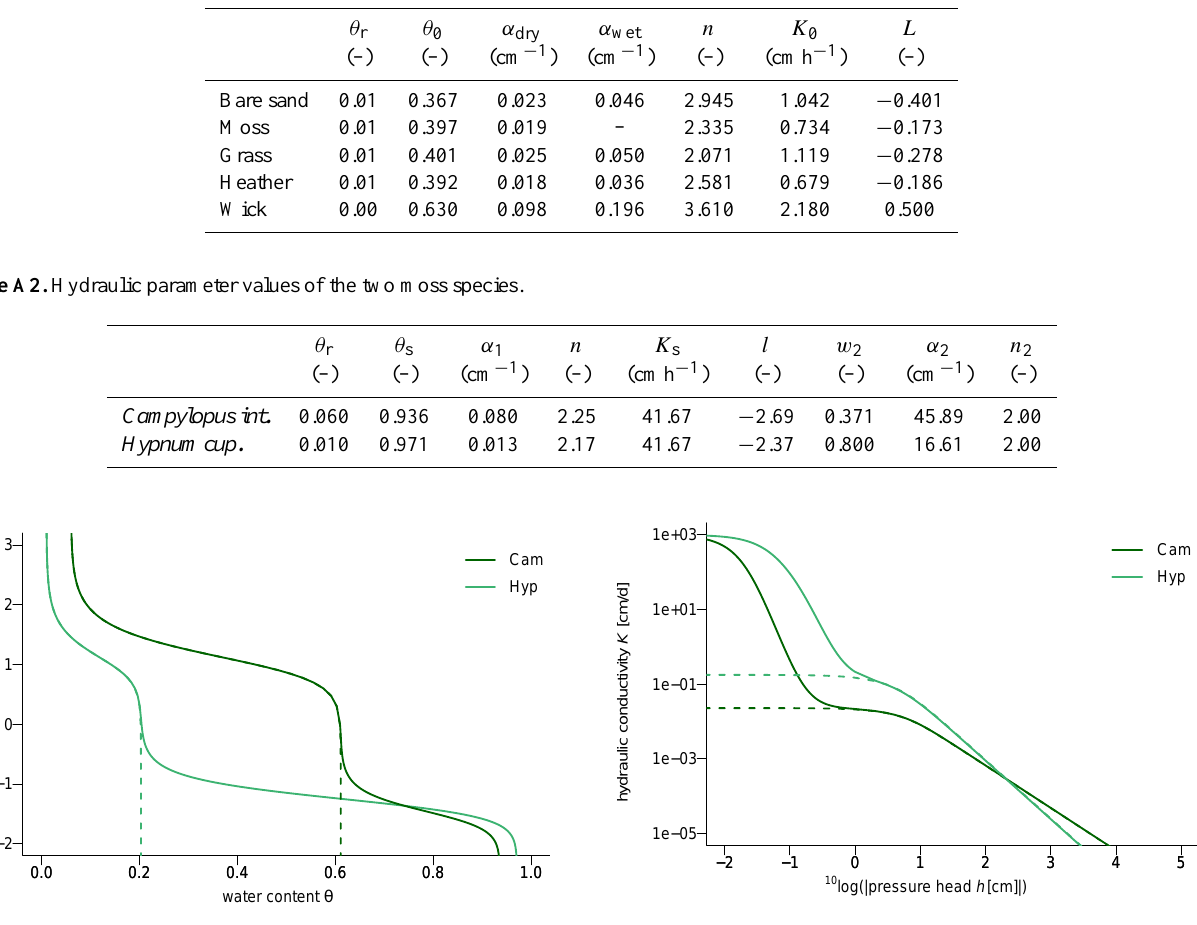
Table A1. Hydraulic parameter values of lysimeter soils.